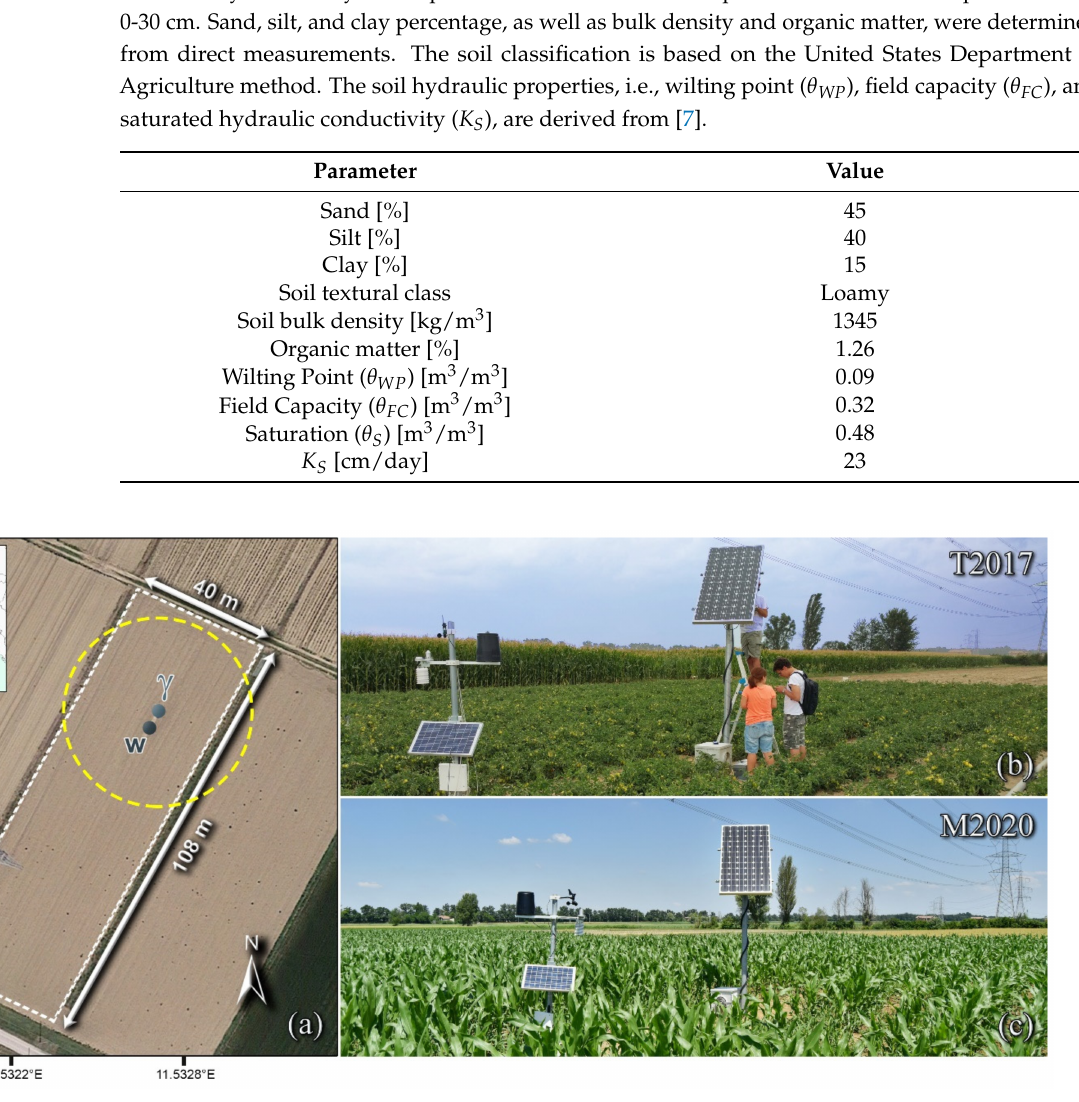
Figure 2. ( a ) The agricultural test field at Acqua Campus (Emilia Romagna, Italy), together with the positions of the PGRS ( γ ) and agro-meteorological (w) stations (geographic reference system WGS 84). The yellow circle around the PGRS station represents the corresponding field of view (FOV) (radius ~25 m). ( b ) Picture of the two stations in 2017 (tomato crop). ( c ) Picture of the two stations in 2020 (maize